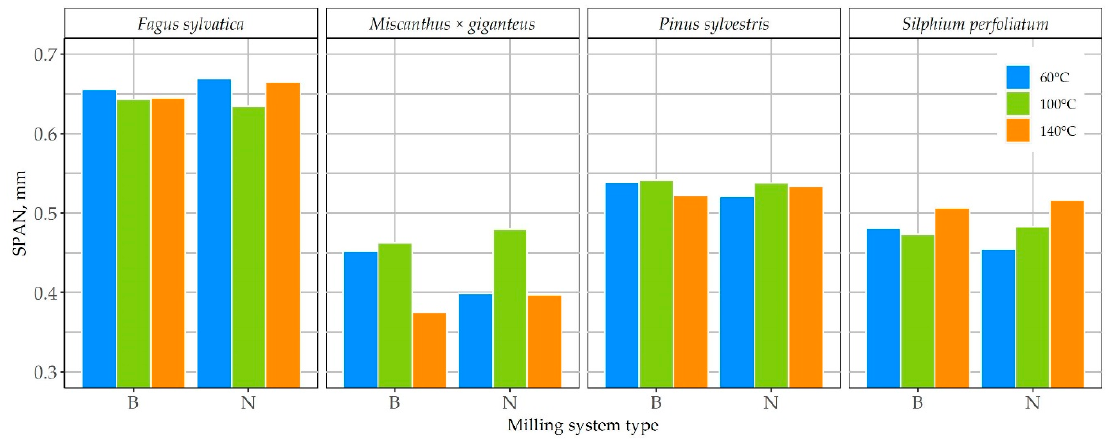
Figure 6. Ground materials’ SPAN value, where B is the hammer milling system and N is the knife milling system. milling